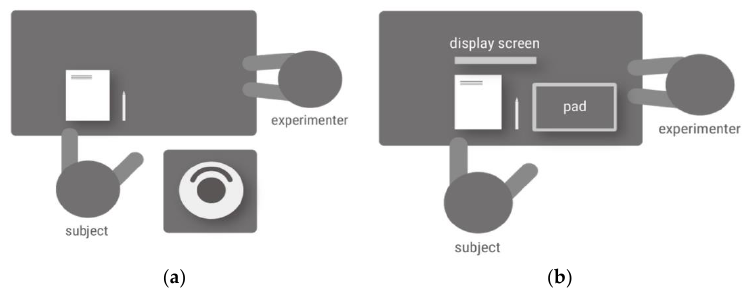
Figure 5. Experimental setting for ( a ) physical product and ( b ) virtual prototypes.